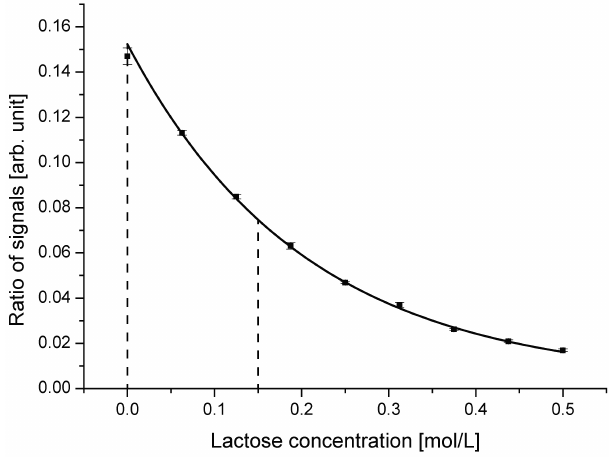
Figure 6. Ratio of reflected to transmitted light signal for the device with an incident angle of 70.0 ◦ . Compared with the device with an incident angle of 72.5 ◦ , the working range is shifted to lower lactose concentrations. The optimal working range is defined between 0 mol/L and 0.150